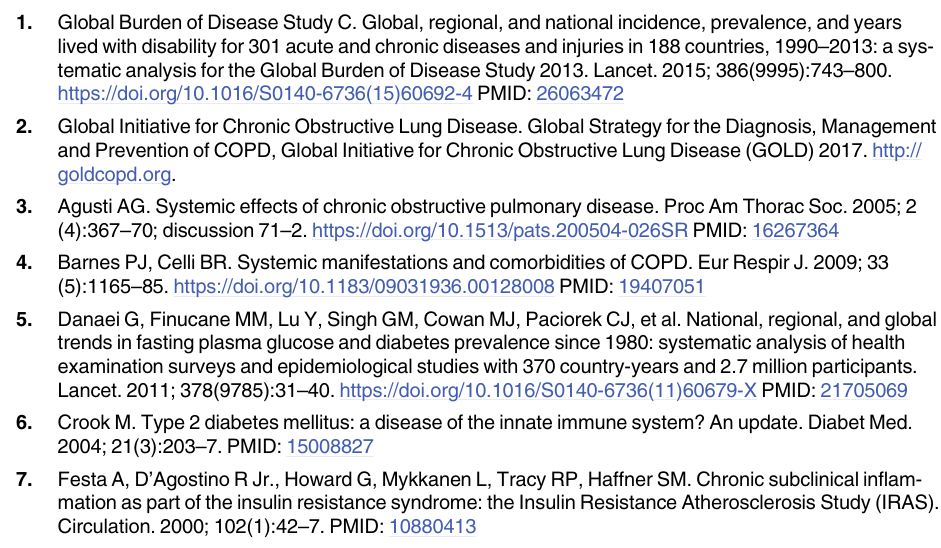
S1 Table. Definitions of